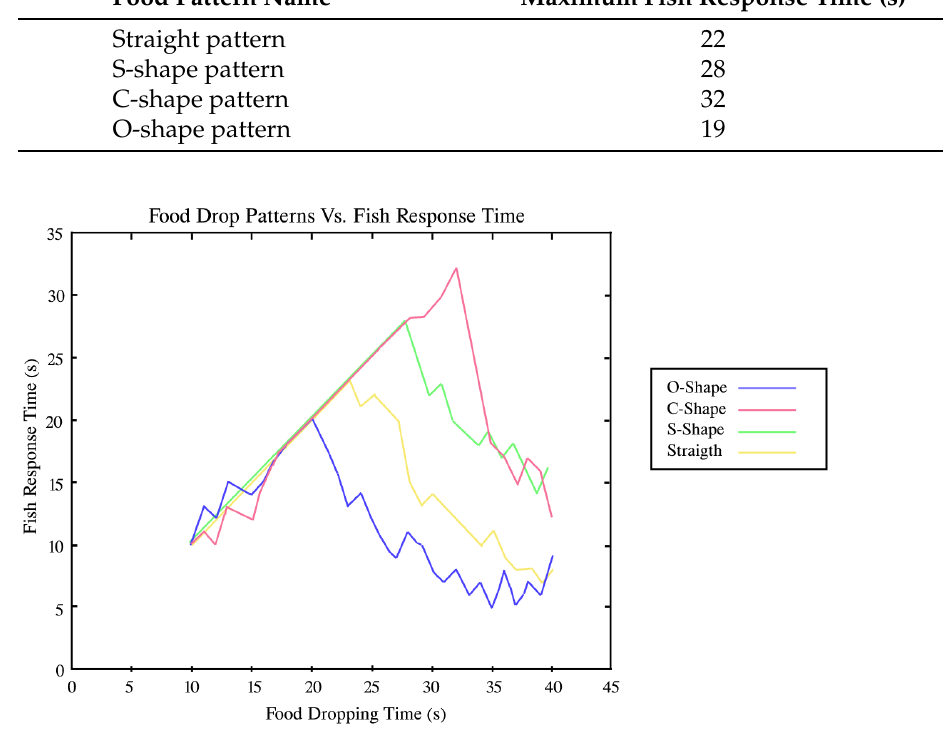
Figure 13. Fish responses for each of the food drop patterns.